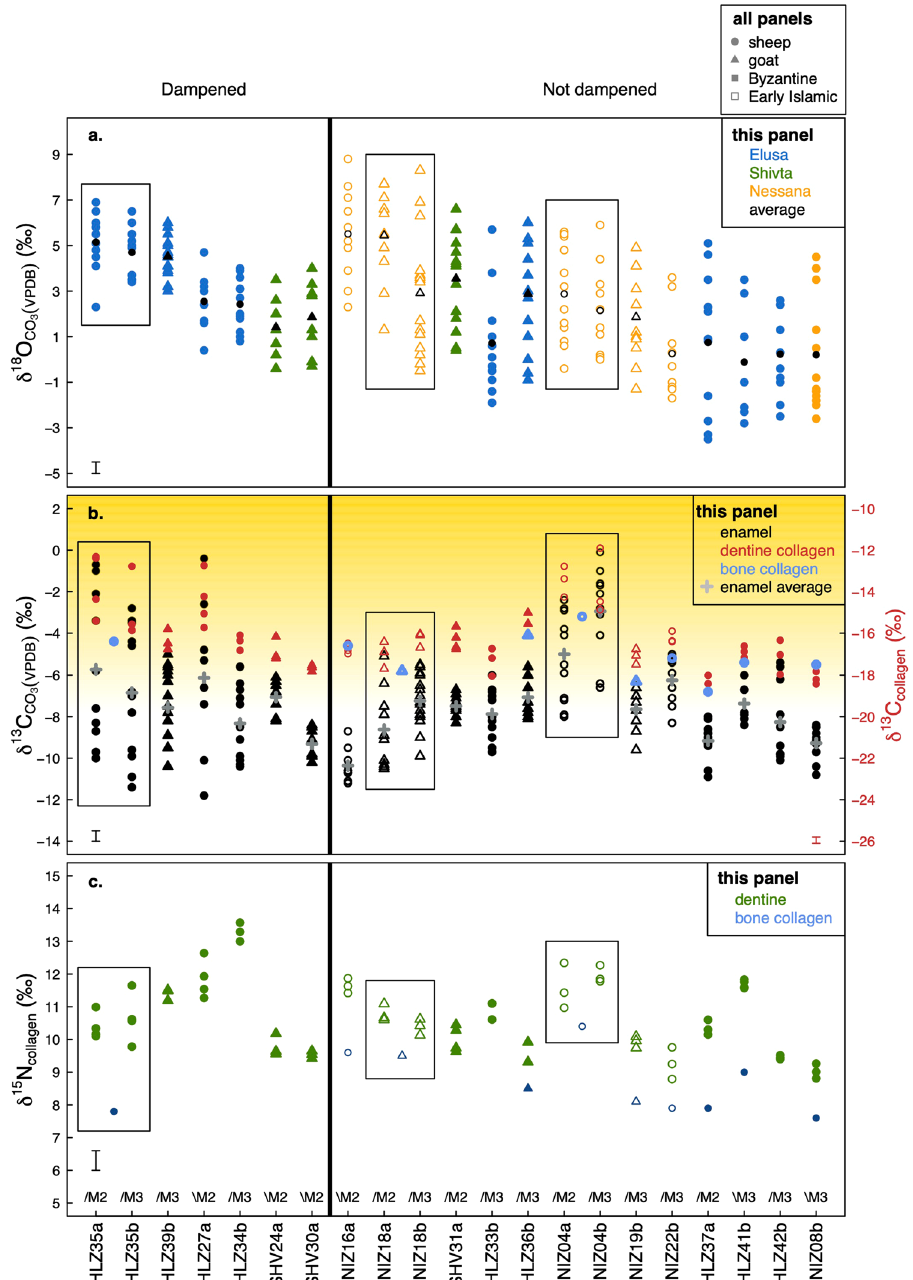
Figure 2. Results of stable isotopic measurements of all teeth carried out in this study. ( a ) δ 18 O values of tooth enamel carbonate. ( b ) δ 13 C values of tooth enamel carbonate, tooth dentine collagen and mandibular bone collagen. The shading indicates increasing contribution of C 4 grasses in the herbivores’ diet, with the lower endpoint at − 8‰ for carbonate δ 13 C values 44 and − 20‰ for collagen δ 13 C values. ( c ) δ 15 N values of tooth dentine collagen and mandibular bone collagen. Individuals were divided into groups based on the amplitude of δ 18 O variation ( Δ 18 O). See text for details. M2 = second molar. M3 = third molar. / denotes lower molar. \ denotes upper molar. Boxes indicate the same individuals. Measurement error (pooled standard deviation of accuracy and precision, see Supplementary Files S1 and S2) shown in bottom left of panels A and C and bottom left and right of panel